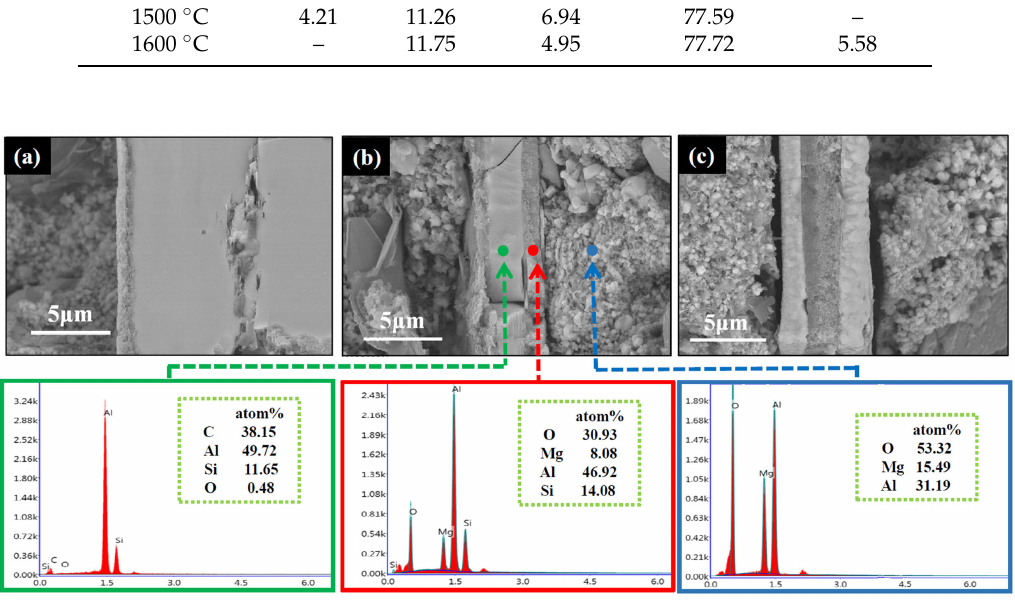
Table 1. Phase compositions of the oxidized samples at different temperature calculated based on Rietveld.